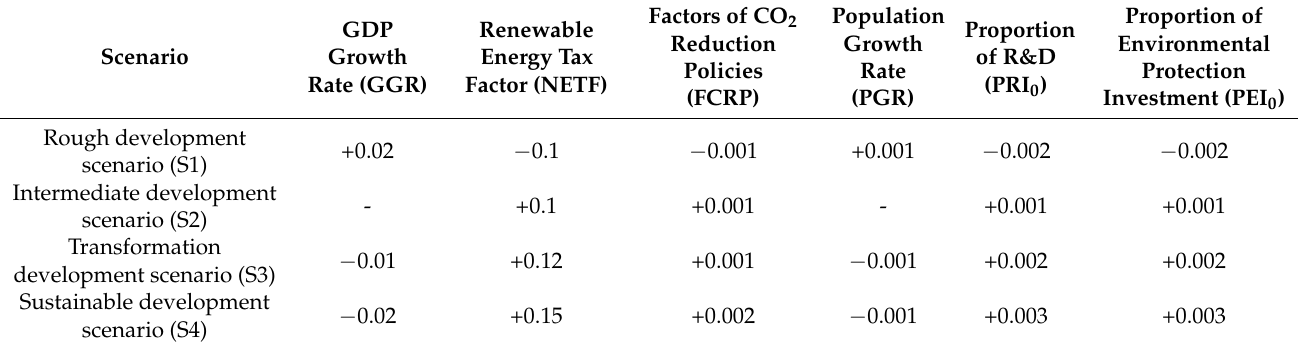
Table 3. Main factors of scenario